Question: Reading the figure, is the described quantity rising or falling?
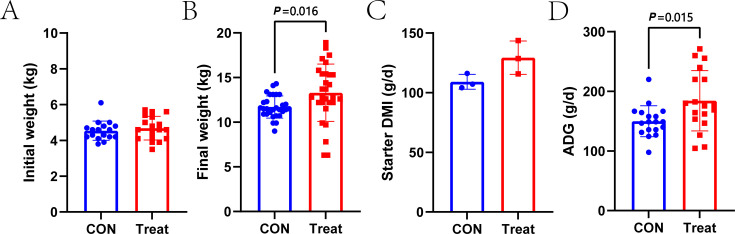
Answer: increasing